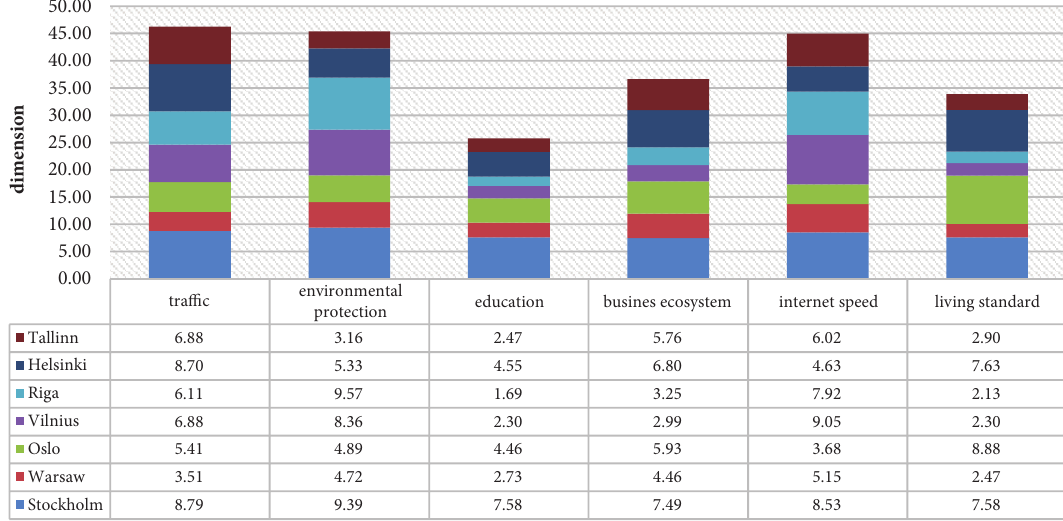
Figure 1. 7 Baltic region cities smartness